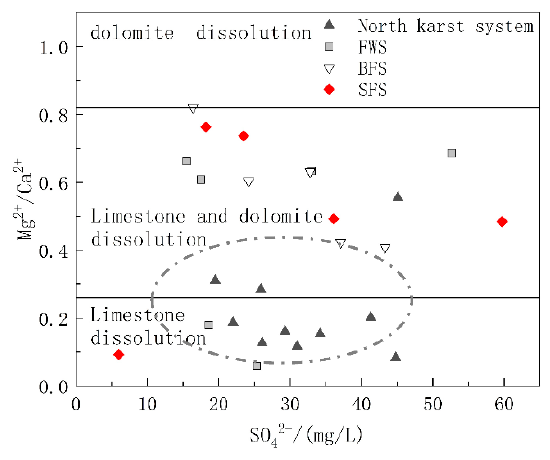
2 + / Ca 2 + and SO 42 − in underground water Figure 7. Relationship of Mg 2+ /Ca 2+ and SO 42− in underground water samples. Figure 7. Relationship of Mg